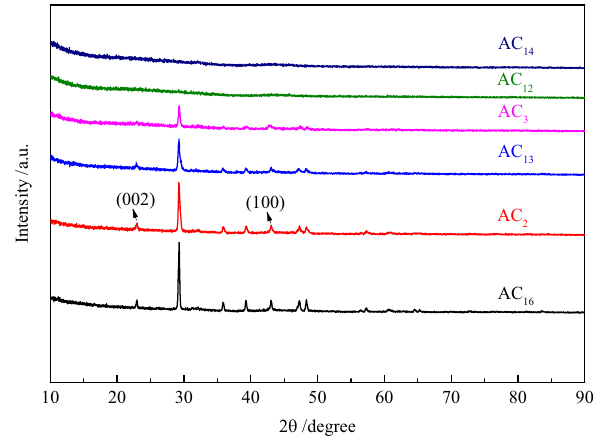
Figure 7. XRD patterns of SACs.